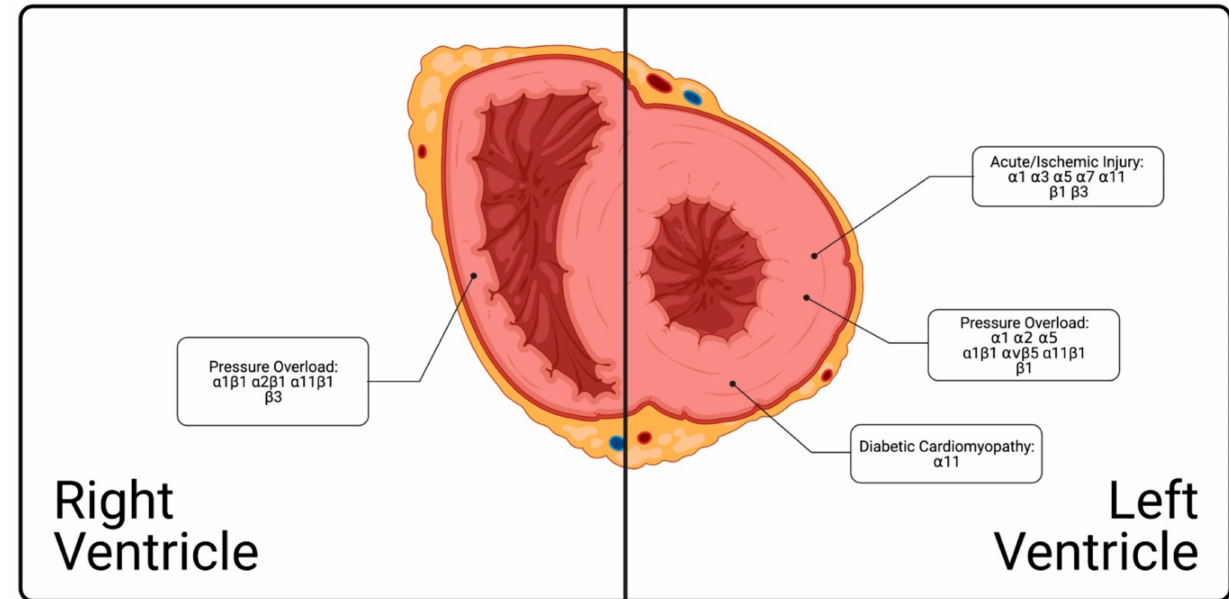
Figure 4. Summary of the current understanding of integrin involvement in left ventricular and right ventricular cardiac fibrosis. In the right ventricle, integrins α 1 β 1, α 2 β 1, α 11 β 1, and β 3 have shown modified expression under pressure overload conditions. In the left ventricle, integrins α 1, α 3, α 5, α 7, α 11, β 1, and β 3 have shown modified expression in acute/ischemic injury; α 1, α 2, α 5, α 1 β 1, α v β 5, α 11 β 1, and β 1 in pressure overload; and α 11 in diabetic